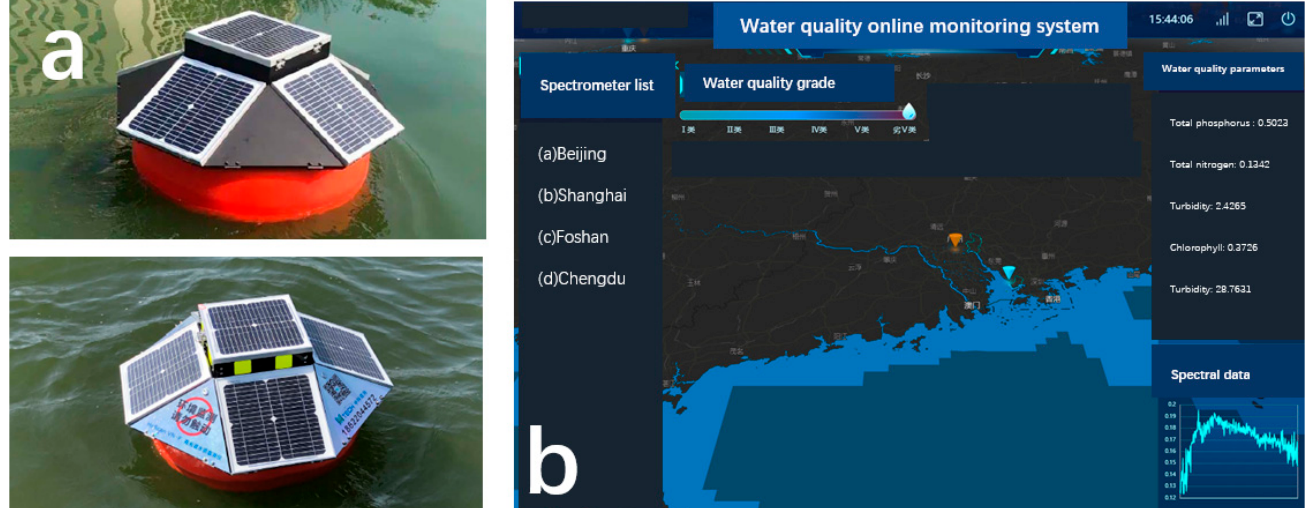
Figure 3. The system is composed of an intelligent water quality spectrometer and data analysis cloud service platform. ( a ) The water quality spectrometer is fixed on the water surface, collects spectral data regularly, and transmits it to the cloud service in real-time through 4G/5G network. ( b ) The system supports cloud data storage, statistical analysis, and real-time viewing of the user’s client.